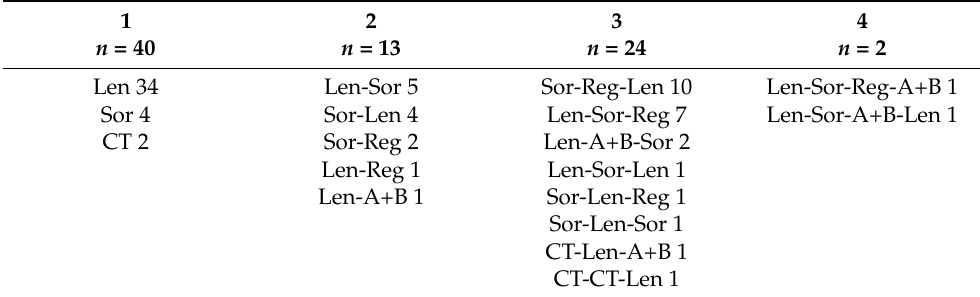
Table 2. Treatment history according to the number of regimens before